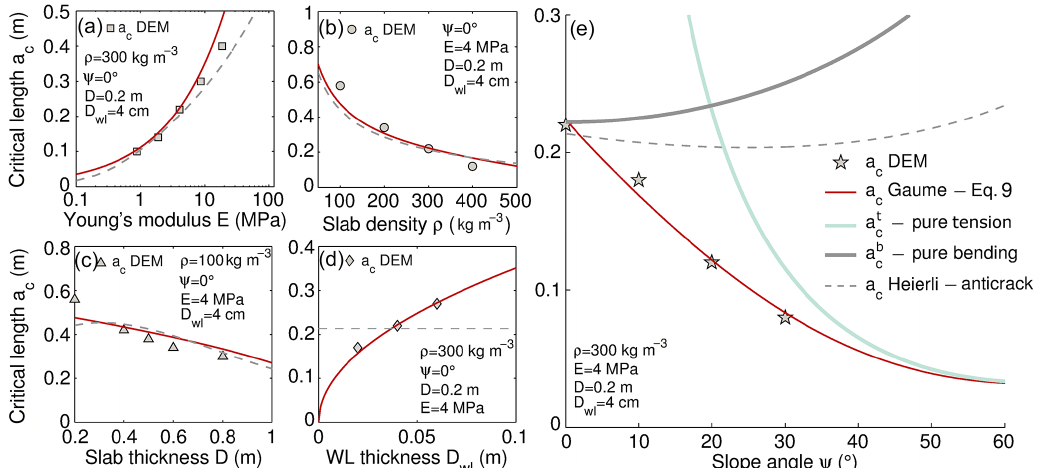
Figure 4. Critical length a c for crack propagation as a function of (a) Young’s modulus E of the slab, (b) slab density ρ , (c) slab thickness D , (d) WL thickness D wl , and (e) slope angle ψ . The symbols represent the critical length obtained from the DEM simulations and the solid lines represent the critical length modeled from Eq. (9) and for different failure behaviors. Dashed lines indicate the critical length obtained with the anticrack model (Heierli et al., 2008) assuming w f = 0 . 1Jm − 2